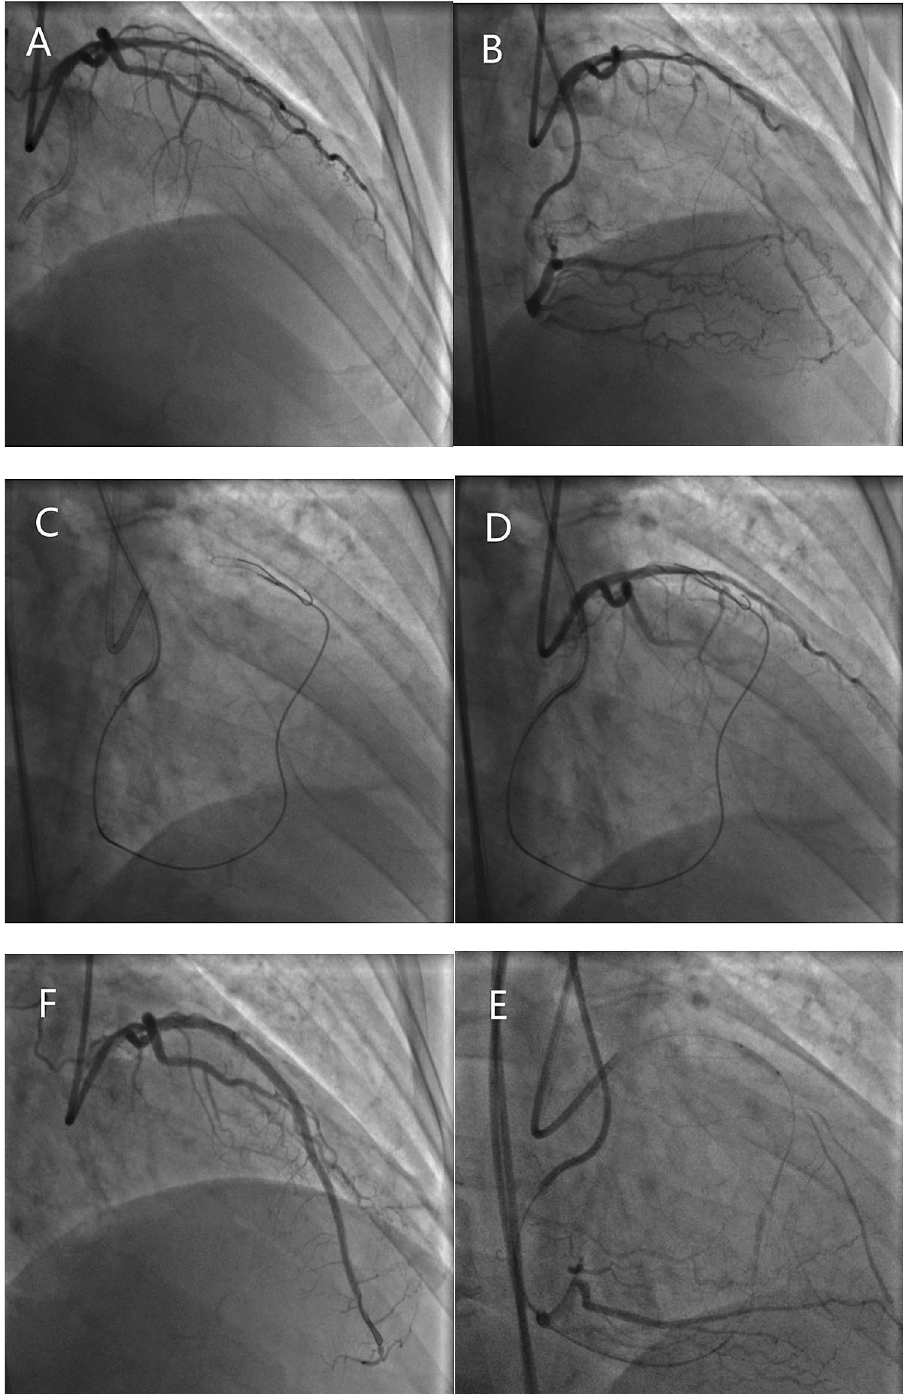
Figure 1. SB was obstructed during recanalization of CTO using RDR technique A CTO in the left anterior descending artery with a significant diagonal branch in the proximal cap. (B) Distal filling by contralateral collaterals from the right coronary artery. (C) Retrograde approach through a septal channel. (D) RDR technique crossed to the true lumen. (E) Balloon dilation of the main vessel without SB protection. (F) After implantation of the main vessel stents, the SB was obstructed with TIMI flow grade 1. CTO, chronic total occlusion; RDR, retrograde dissection and reentry; SB, side